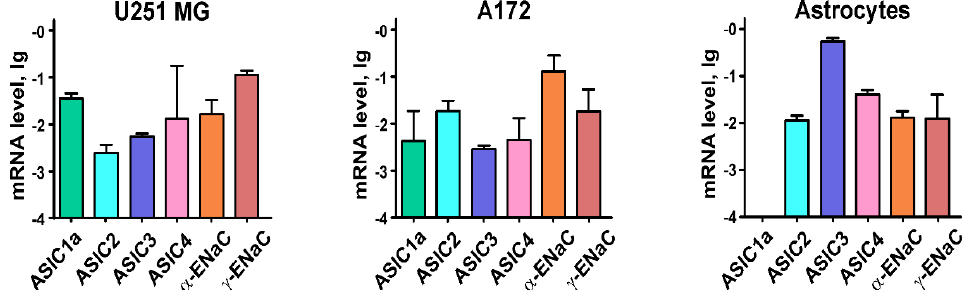
Figure 1. qPCR analysis of Acid-sensing Ion Channels (ASICs) and epithelial Na + channels (ENaCs) mRNA expression in U251 MG and A172 cells and normal astrocytes. Gene expression was normalized to the β - ACTIN , GPDH and RPL13a housekeeping genes and presented as lg of relative mRNA level ± standard error of mean (SEM) ( n = 3–5).